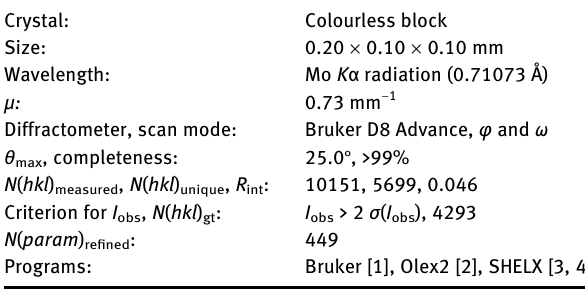
Table  : Data collection and